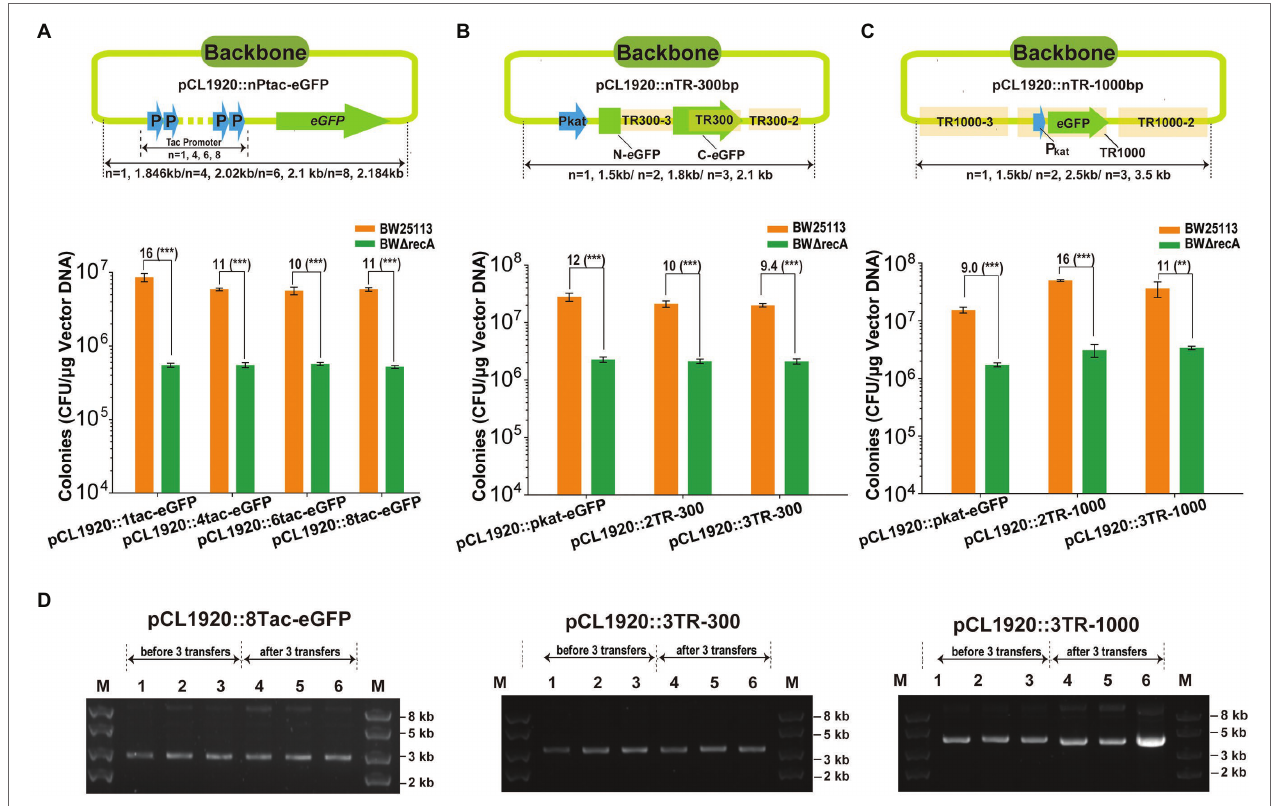
FIGURE 8 | The cloning of plasmids with TRs at different lengths in E. coli BW25113. (A) DNA fragments containing an eGFP gene under the control of 1, 4, 6, and 8 units of the 41-bp Ptac was assembled into pCL1920. (B) DNA fragments containing 1, 2, or 3 units of the 300-bp TRs (TR300), derived from the C-terminal eGFP gene, were assembled into pCL1920. (C) DNA fragments containing 1, 2, or 3 units of the 1,000-bp TRs (TR1000), included the Pkat and eGFP, were assembled into pCL1920. The constructs were transformed into E. coli BW25113 and BW25113 Δ recA, and the total transformant colonies on LB plates with antibiotic selection were counted. Unpaired t-tests were performed (*** = p < 0.001). The numbers before (***) represent the difference by folds. Data are averages of three samples with standard deviations (error bars). (D) Gel electrophoresis of pCL1920::8Tac-eGFP, 3TR-300 bp, and 3TR-of 1,000 bp. Lanes 1–3 in each figure represent plasmids extracted from the three cultures before 3 transfers, and lanes 4–6 in each figure represent plasmids extracted from the three cultures after 3 transfers. Lane 1–2 and 4–5 represent plasmids extracted from BW25113, and Lane 3 and 6 represent plasmids extracted from the strain BW Δ